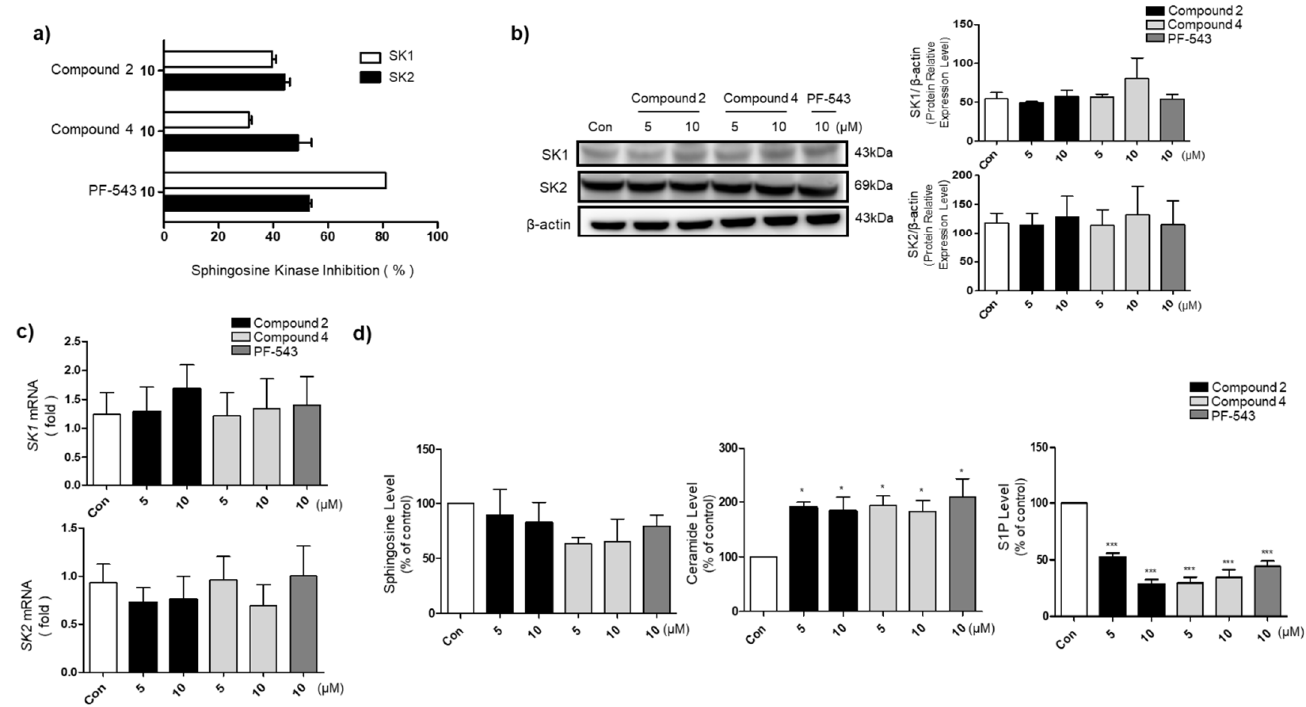
Figure 3. Effects of PF-543 and PF-543 derivatives on A549 cells biological result; ( a ) Activities of SK1 and SK2 at 10 µ M concentrations of PF-543 and PF-543 derivatives; ( b ) Protein was extracted and detected SK1, SK2, and β -actin protein levels by Western blotting. Each protein level was normalized by β -actin. Western blot was performed in three independent experiments; ( c ) The mRNA levels of SK1 and SK2 were quantified by qRT-PCR by treating A549 cells with PF-543 or PF-543 derivatives at 5 and 10 µ M for 24 h. SK1 and SK2 mRNA was normalized to cyclophilin; ( d ) Sphingosine, ceramide, and S1P levels were measured in A549 cells with 5 and 10 µ M PF-543 and PF-543 derivatives. The data are expressed as the mean ± S.D. * p < 0.05, *** p < 0.001 compared with control group.